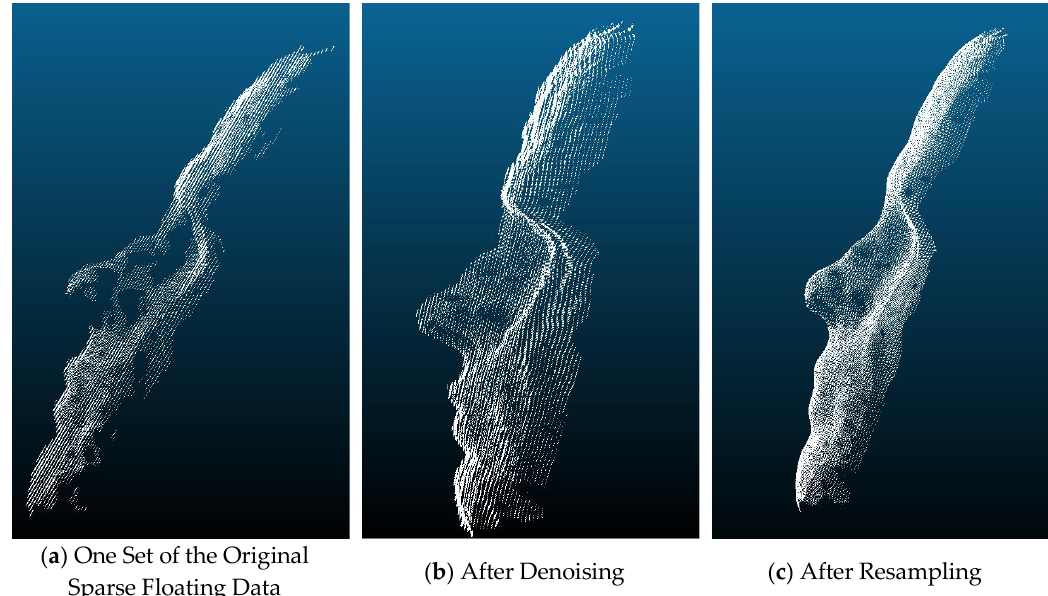
Figure 2. Simulated effects of denoising and resampling of the original floating data.